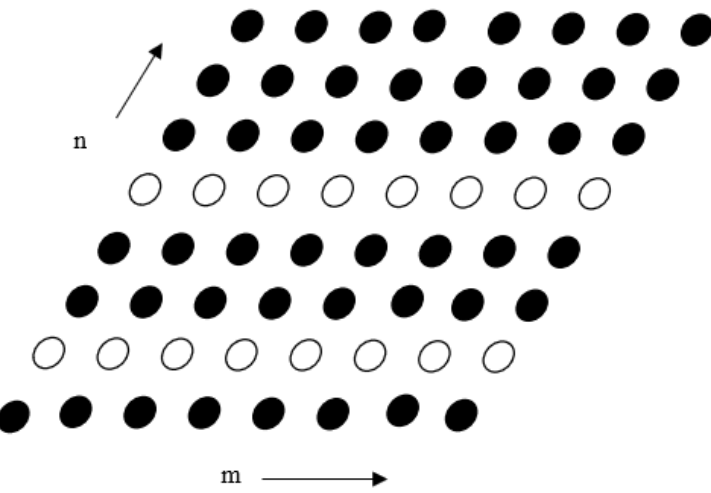
Figure 3. Failed elements in a planar array with non-uniform inter-element distance.